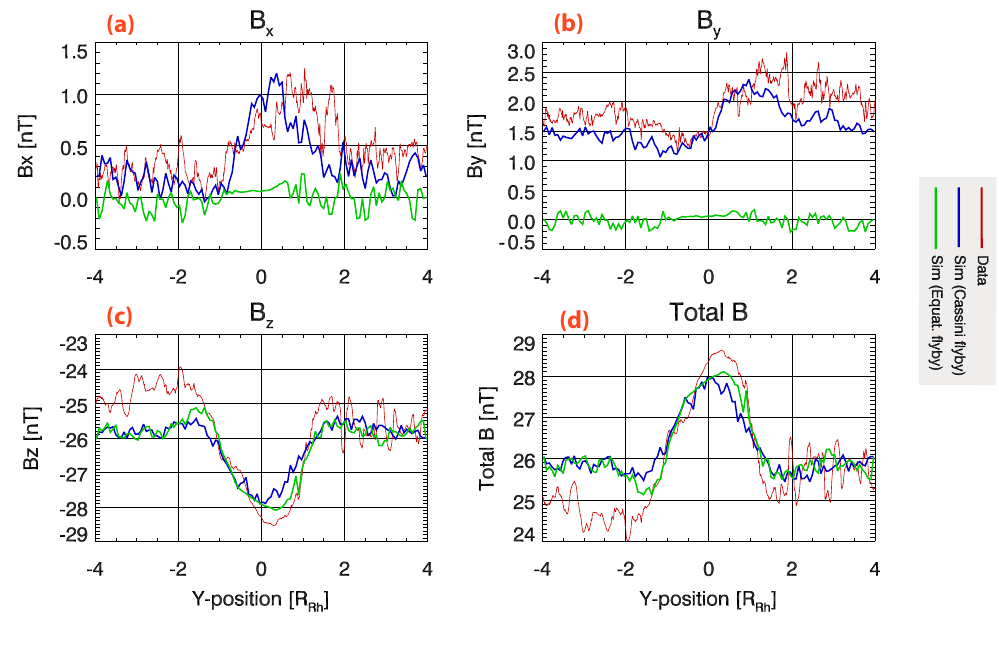
Fig. 11. Comparison of the simulation results with the magnetometer data from the Cassini flyby. In green color we also show the magnetic field signature on an equatorial trajectory in the wake along the y-axis, from the “ideal case” run.